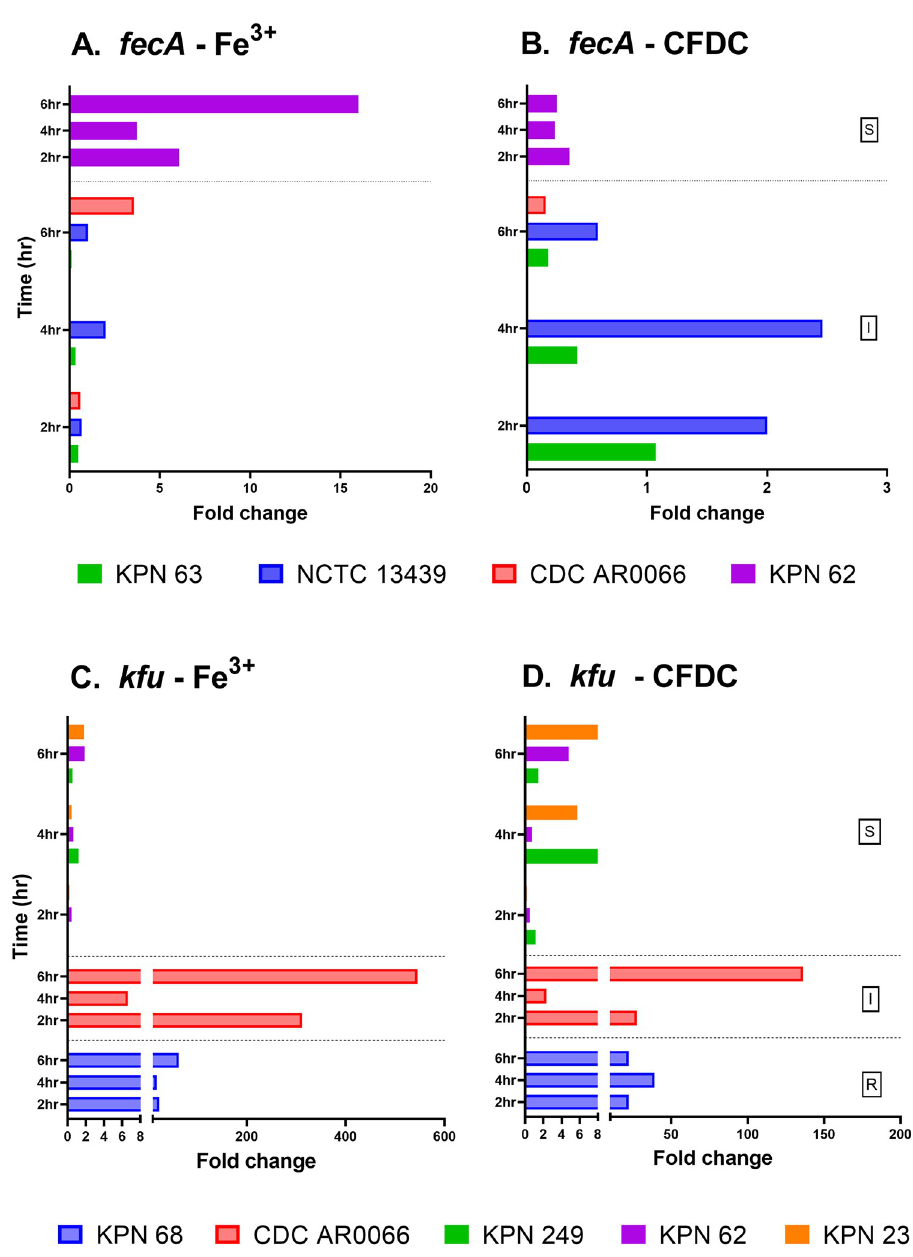
Fig 5. Iron transport gene expression of strains overtime in different media. Fold changes of expression were calculated for strains grown in different media by comparing the expression of each gene for bacteria treated with CFDC or grown in iron enriched media to the expression of the same gene at the same time point when the bacteria were grown in iron depleted media. than bacteria treated with CFDC ( p = 0.015). After checking GE patterns in heatmaps for entB (Fig 6A) and fepA (Fig 6B), both genes were more expressed when bacteria were cultured in iron depleted media with or without CFDC than in iron enriched media. GE of entB was highly variable between strains in I group, as CDC AR0066 under expressed the siderophore while KPN 63 over expressed it when cultured in all three media (Fig 6A). In general, entB was